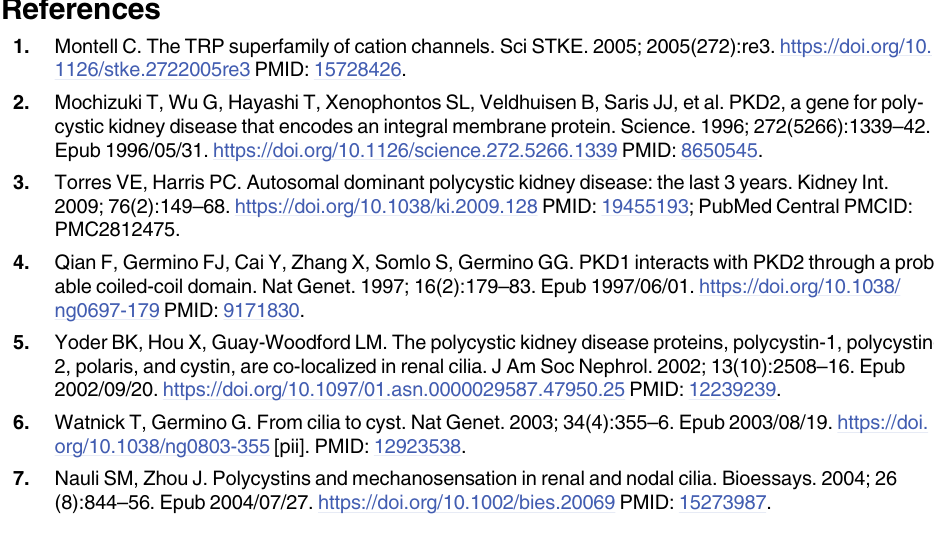
three proteins. Scale bars: 10 μ m. S1 Table. Summary of RT-PCR data. Total RNA was extracted from male and female heads, bodies and relevant reproductive organs and used for cDNA synthesis. Primer pairs as indi- cated in S2A Fig were used for RT-PCR and the data was summarized in table form. n/a: not applicable. See Material and Methods for